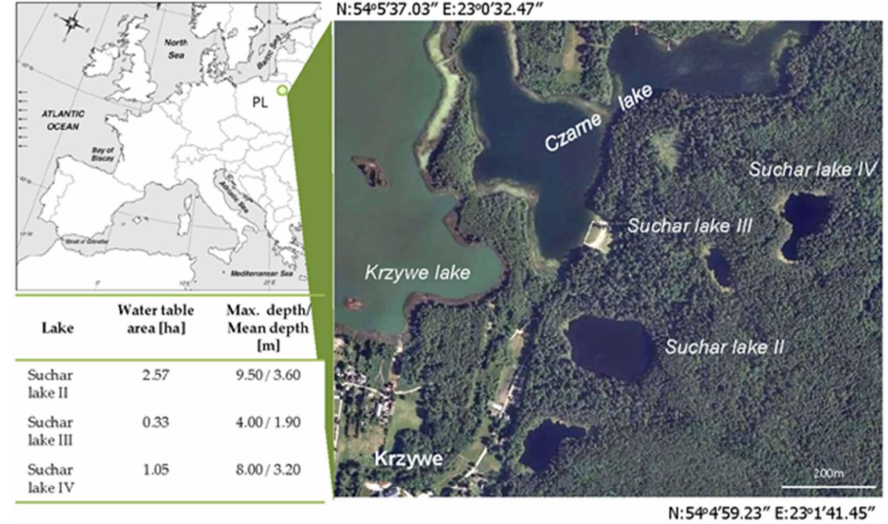
Figure 1. Location of the study area and aerial view on the Suchar lakes II, III, and IV with main morphometric